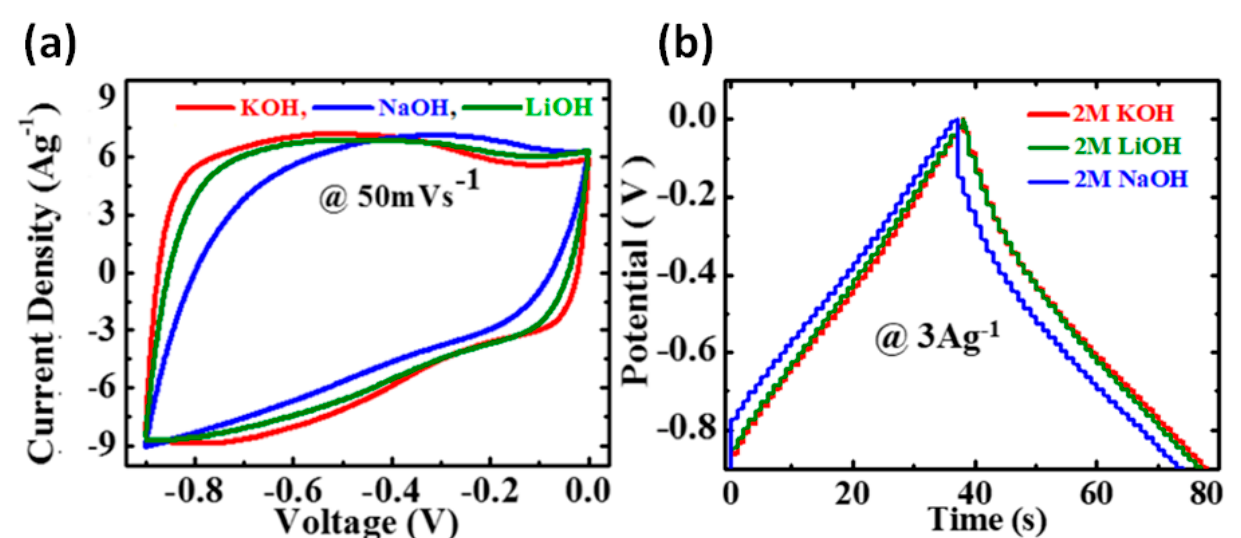
Figure 10. CV curves at 50 mV/s ( a ) and GCD curves at 3 A/g ( b ) of rGO-CNT film with 10 wt.% of CNT (GP10C) in aqueous KOH, LiOH, and NaOH electrolytes [24].